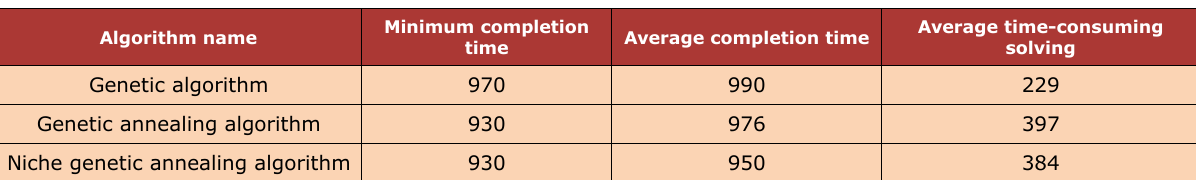
Table 3. Product collaborative innovation design time-consuming in the different